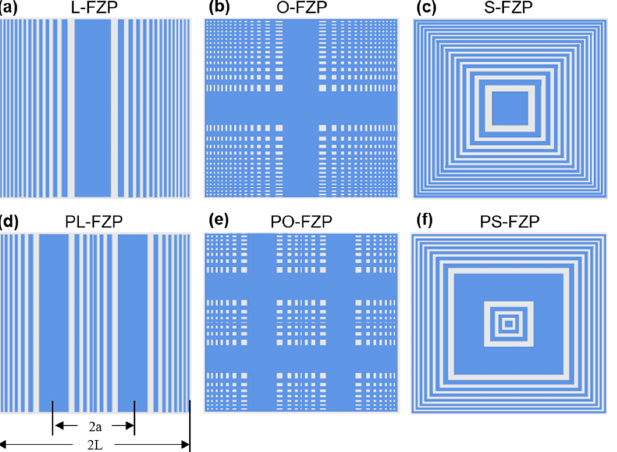
Figure 2. Schematic diagrams of quadrate FZPs: ( a ) L-FZP; ( b ) O-FZP; ( c ) S-FZP; ( d ) PL-FZP; ( e ) PO- FZP; ( f ) PS-FZP.